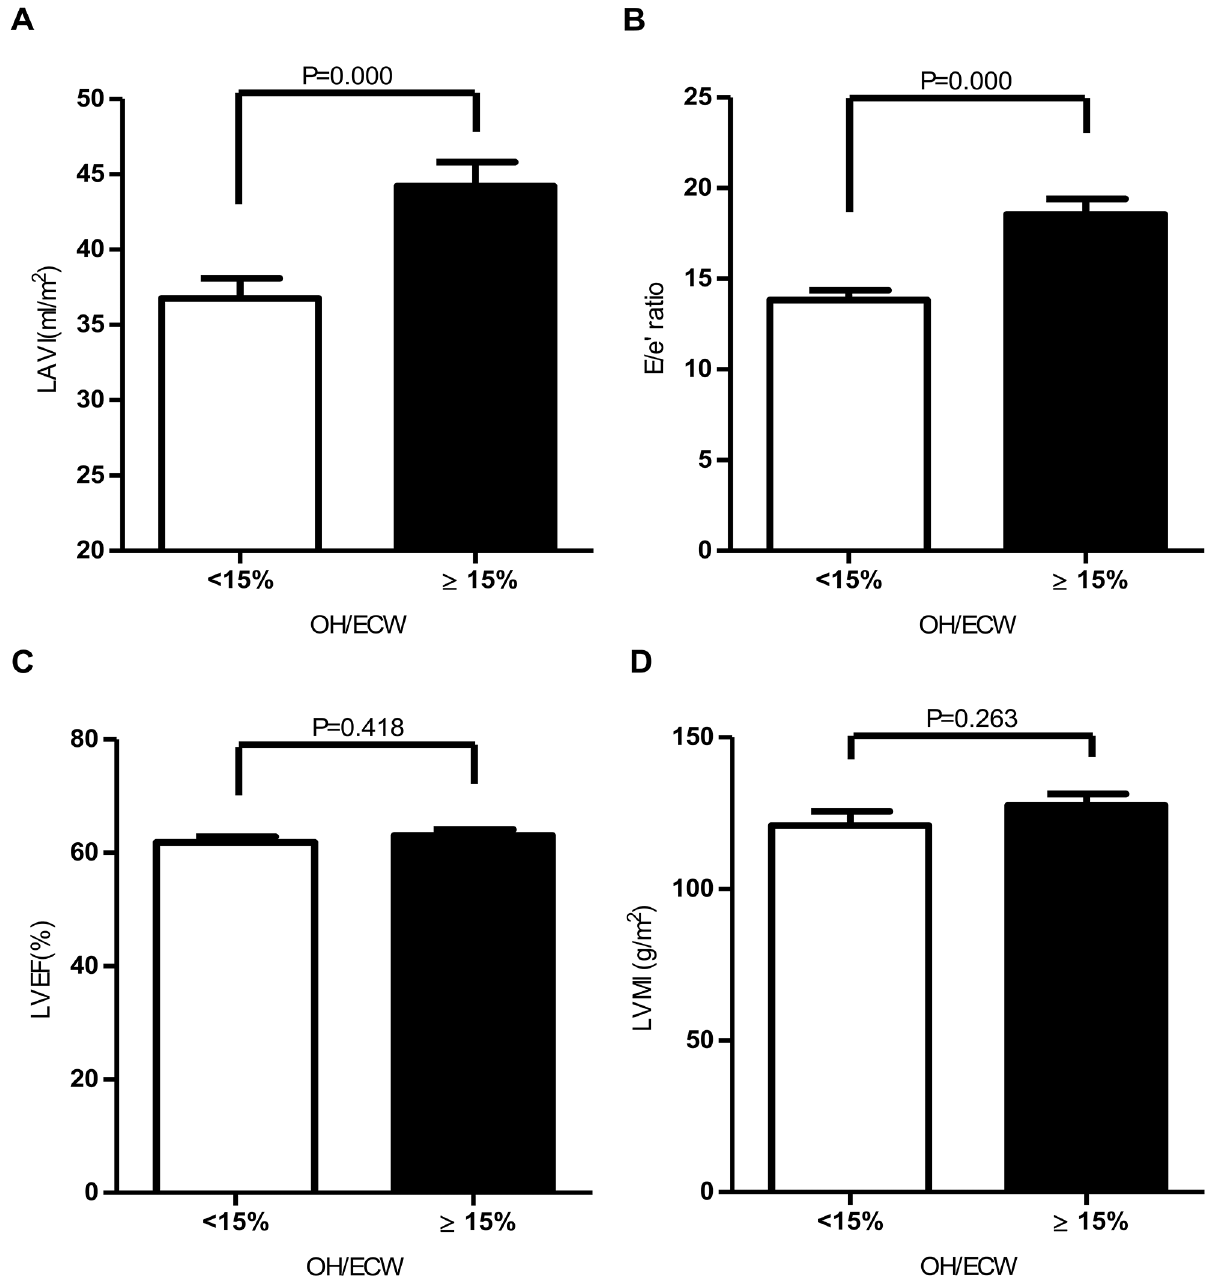
Fig 1. Comparison of left atrial volume index (LAVI) (A), E/e´ ratio (B), left ventricular ejection fraction (LVEF) (C), and left ventricular mass index (LVMI) (D) between non-overhydrated and overhydrated groups.